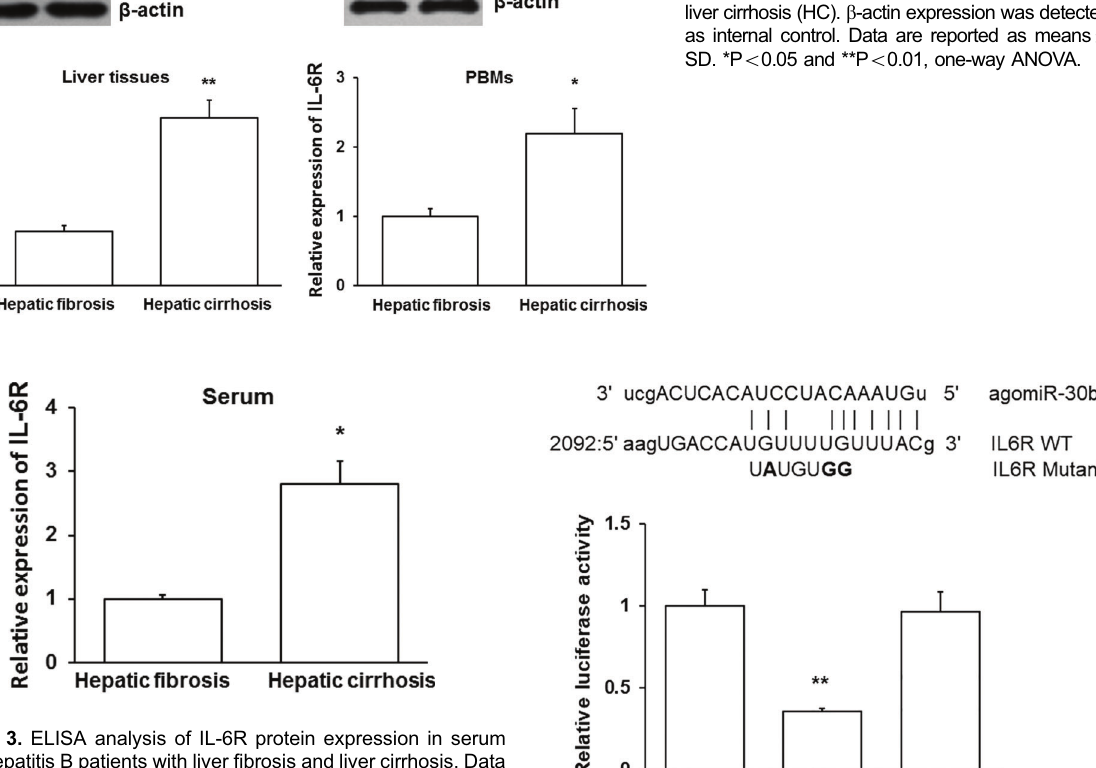
Figure 2. Relative protein expression by western blot analysis of IL-6R protein expression. A , Liver tissues, and B , peripheral blood monocytes (PBMs) from hepatitis B patients with liver fi brosis (HP) or liver cirrhosis (HC). b -actin expression was detected as internal control. Data are reported as means ± SD. *P o 0.05 and **P o 0.01, one-way ANOVA.